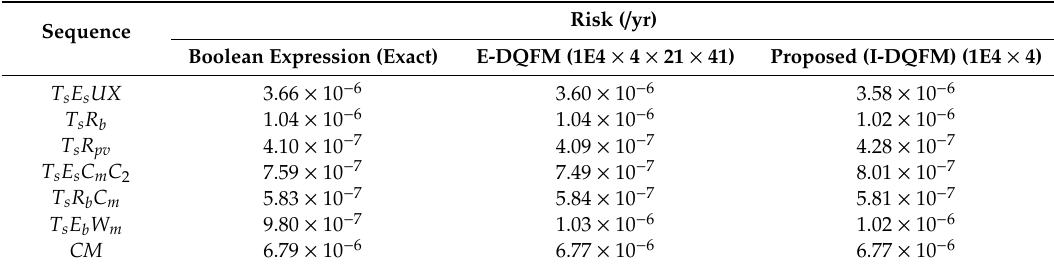
Table 8. Mean multi-hazard risk for “LGS NPP”: Fully correlated case.